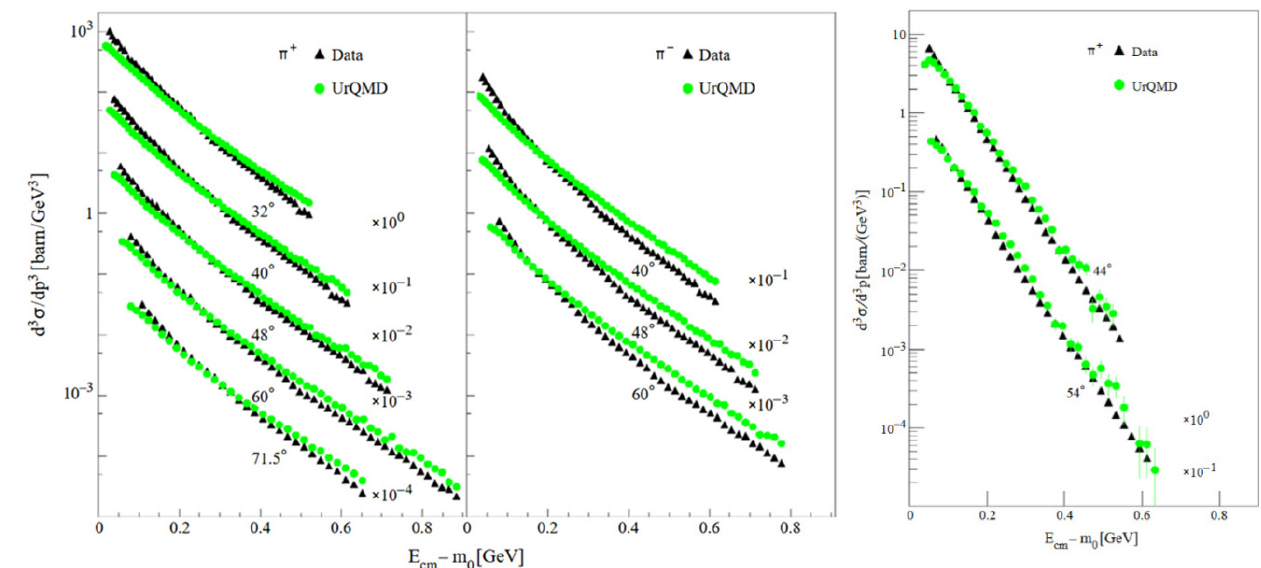
Figure 4. Differential pion production cross-sections measured at various polar emission angles in Au+Au collisions at 1.5A GeV ( π + left panel and π − center panel) and in C+C collisions at 1A GeV ( π + right panel) as a function of the kinetic energy in the c.m. system (black triangles) in comparison to results of URQMD transport calculations (green triangles) [34].